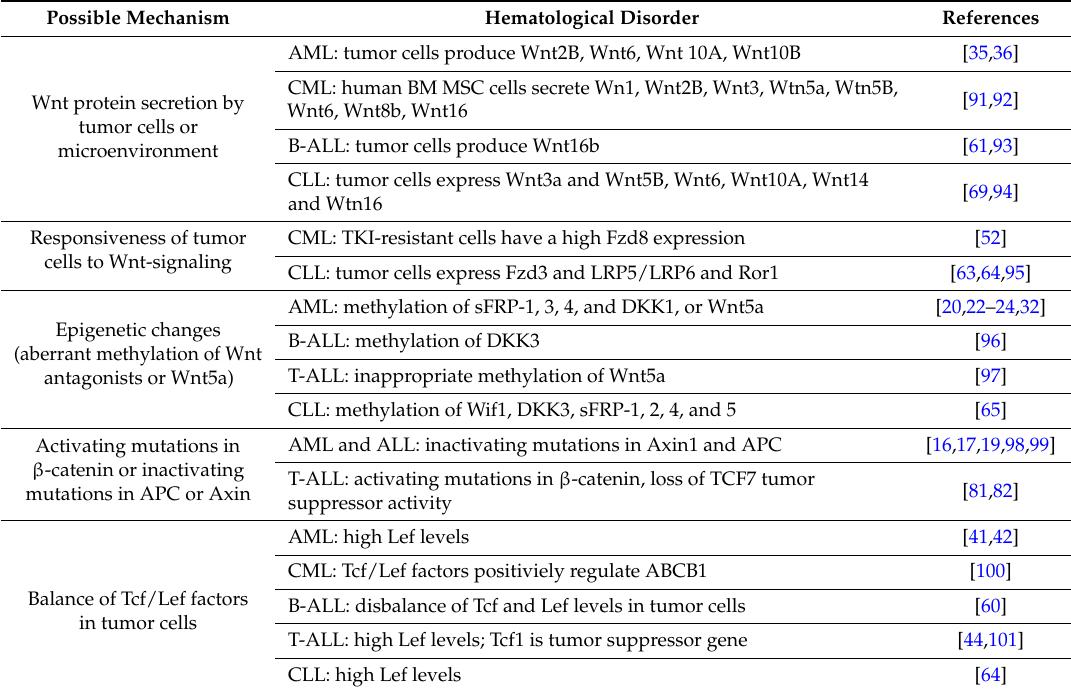
Table 1. Summary of mechanism underlying deregulated Wnt signaling in